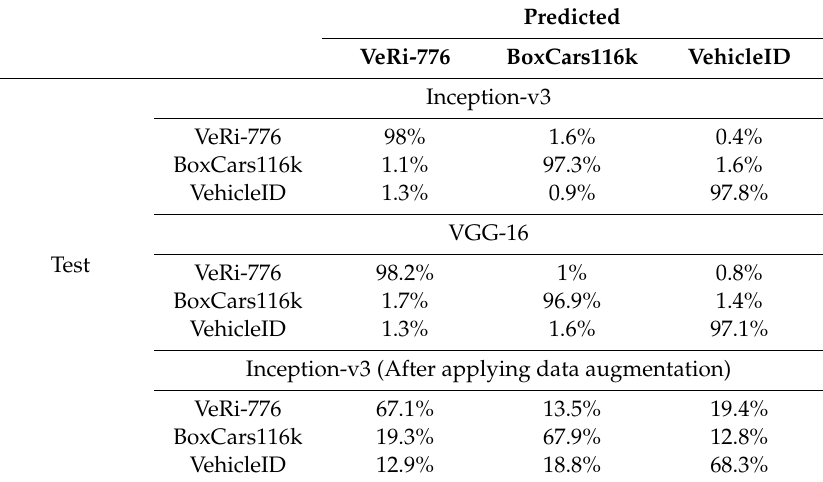
Table 2. Confusion matrix for a classifier trained to predict the parent dataset of a given re-identification (Re-Id) image.